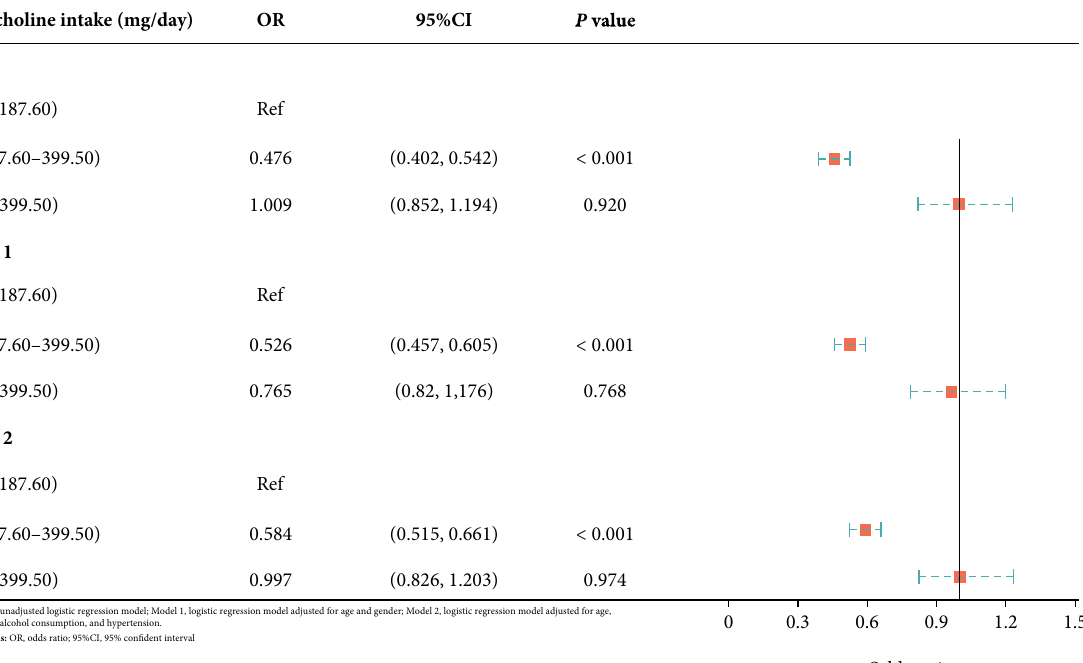
Figure 4: Forest plot-association between choline intake and cognitive performance assessed by the